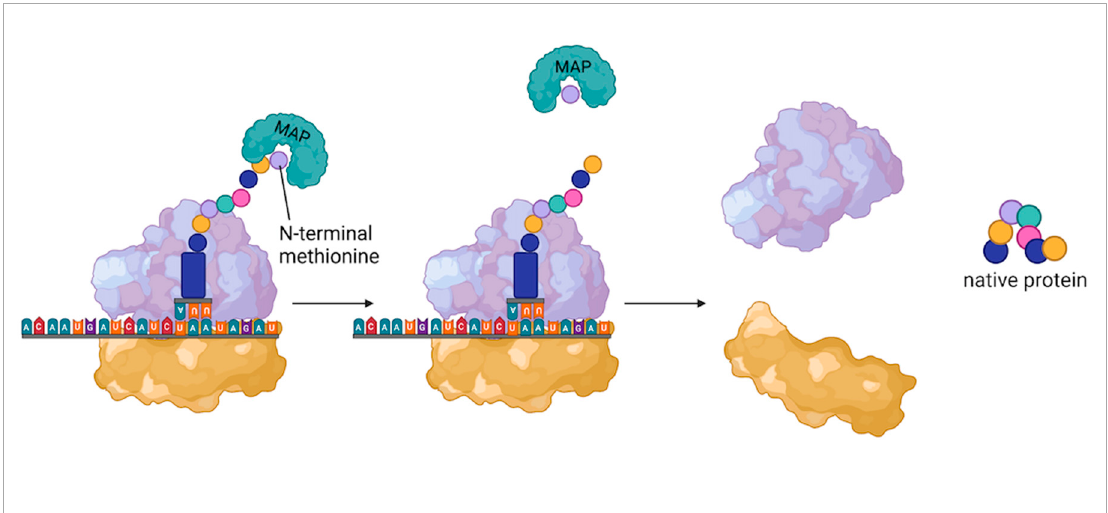
Figure 2. Methionine aminopeptidase acting on N-terminal methionine. This shows general function of methionine aminopeptidase (MAP) in eukaryotic protein synthesis. From left to right shows the binding of MAP to the N-terminal methionine, the removal of the methionine, and the disassociation of the ribosomal subunits leaving the native protein.